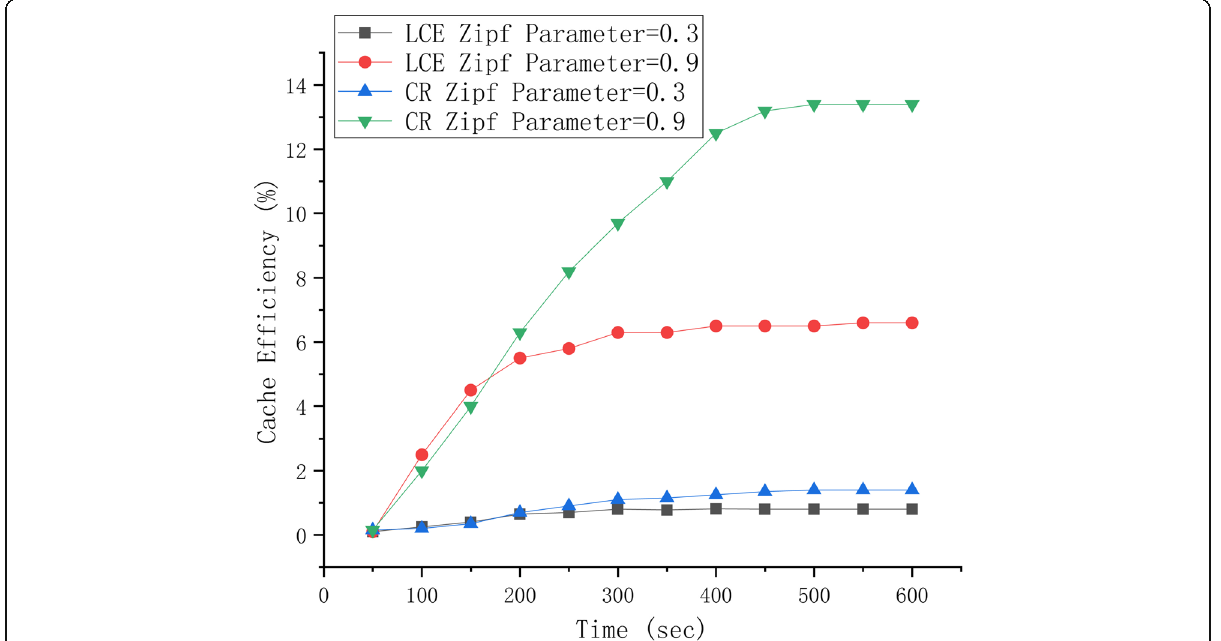
Fig. 10 Cache efficiency vs. time for cross regions. This figure indicates that CR leads LCE in cache hit ratio for both Zipf parameters. The results also show that CR has more advantage when Zipf Parameter is set to 0.9 rather than 0.3. In the 0.9 case, CR more than doubled the cache hit ratio of LCE, indicating that CR provides a better solution to cross-region scenario where user interests differ from one region to